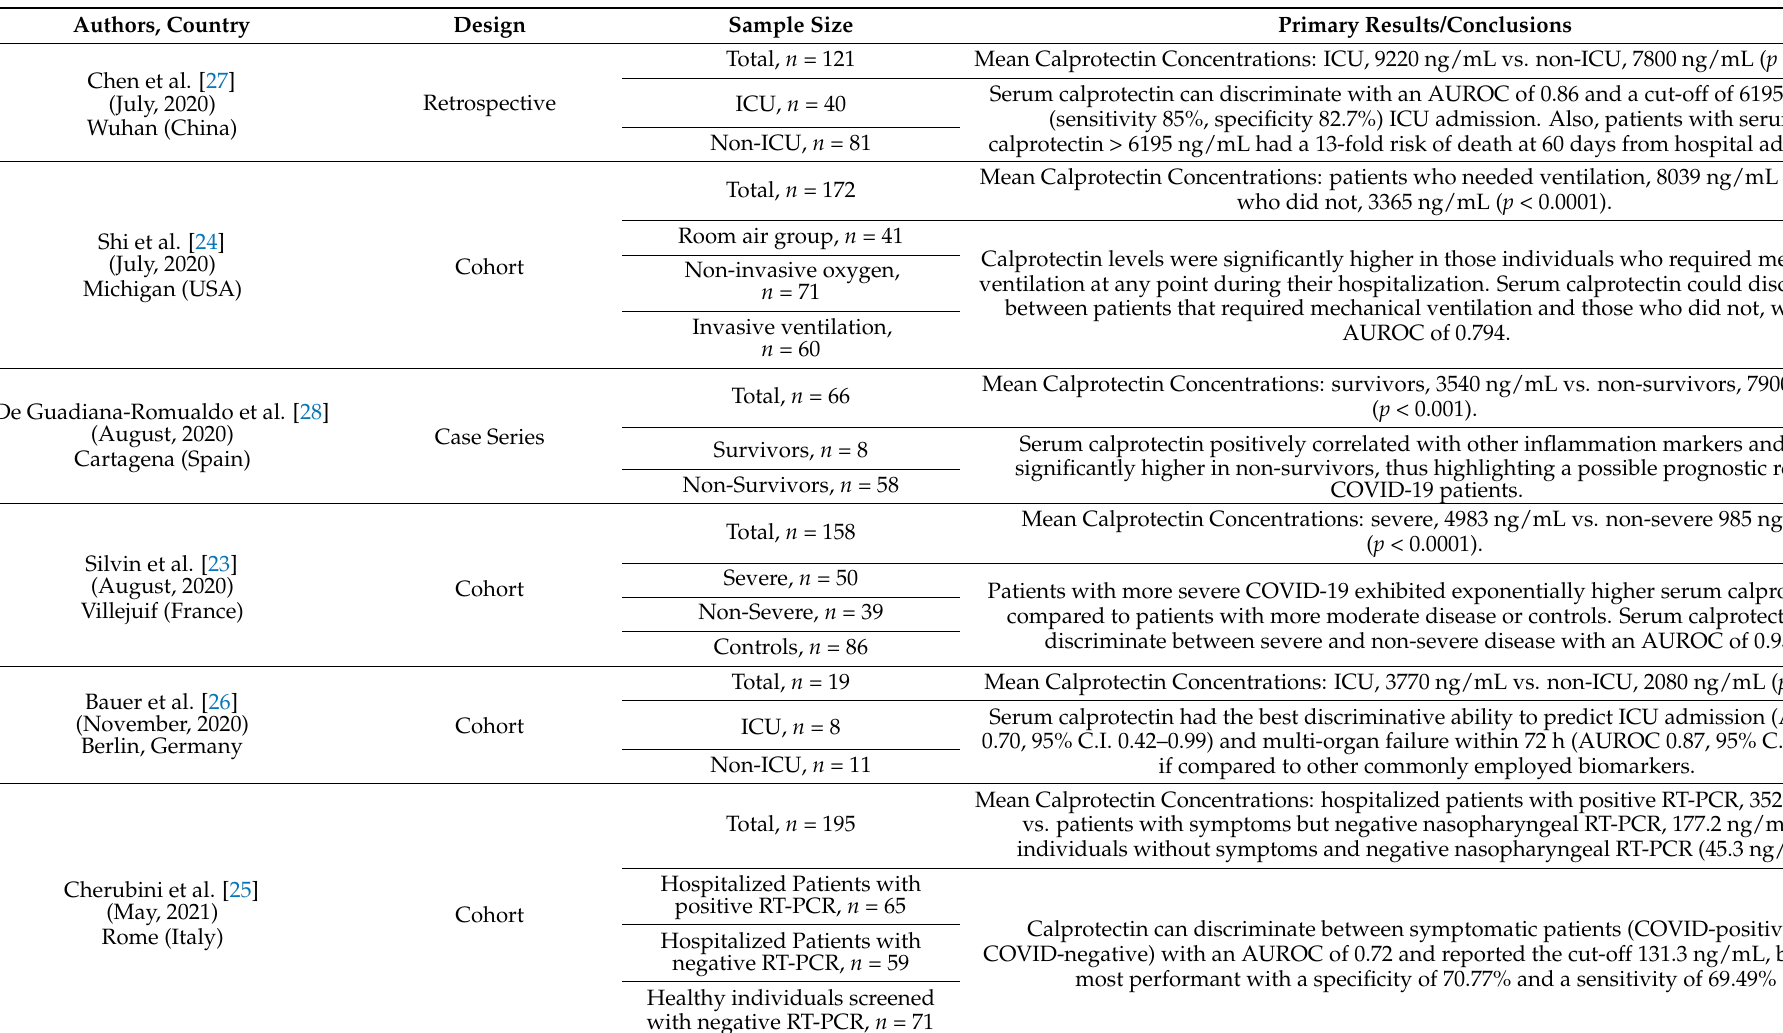
Table 1. Summary of current findings in terms of serum calprotectin and COVID-19. ICU: intensive care unit; CRP: C-reactive proteins; AUROC: area under the receiver operating